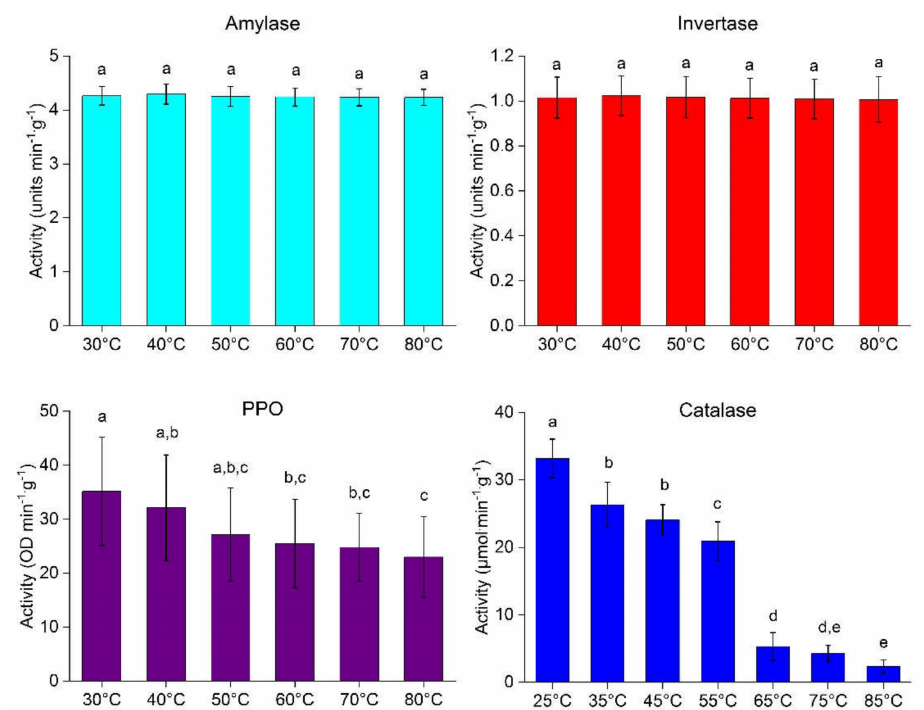
Figure 1. Enzyme activity of amylase, invertase, polyphenol oxidase (PPO) and catalase of mango variety Samar Bahisht (SB) Chaunsa after 10 min incubation of enzyme extract at various temperatures. a–e values with di ff erent letters in the graph represent significant di ff erences p < 0.05, ( n = 18 × 3). Multiple comparisons Tukey honestly significant di ff erence (HSD) test reports for PPO and catalase are provided in Appendix A Tables A1 and A2,